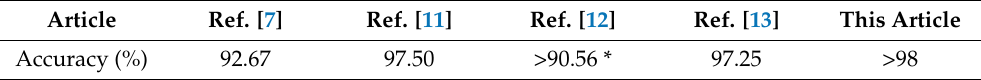
Table 8. Comparison of recognition rate of methods in related